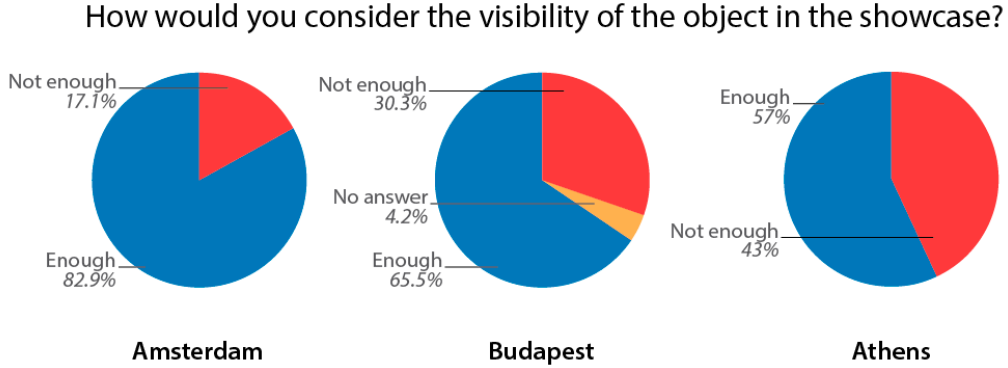
Figure 22. Image representing the results of one of the questions done to museum visitors about the objects’ visibility, at APM, NHM, and BCM.